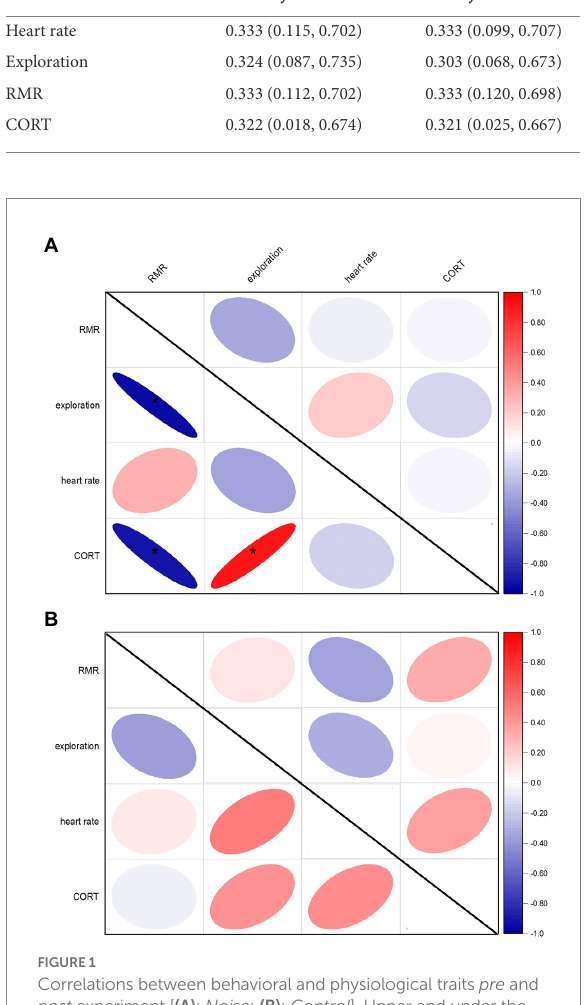
FIGURE 1 Correlations between behavioral and physiological traits pre and post experiment [ (A) : Noise ; (B) : Control ]. Upper and under the diagonal indicated pre and post experiments, respectively. *Suggests significant correlations between two